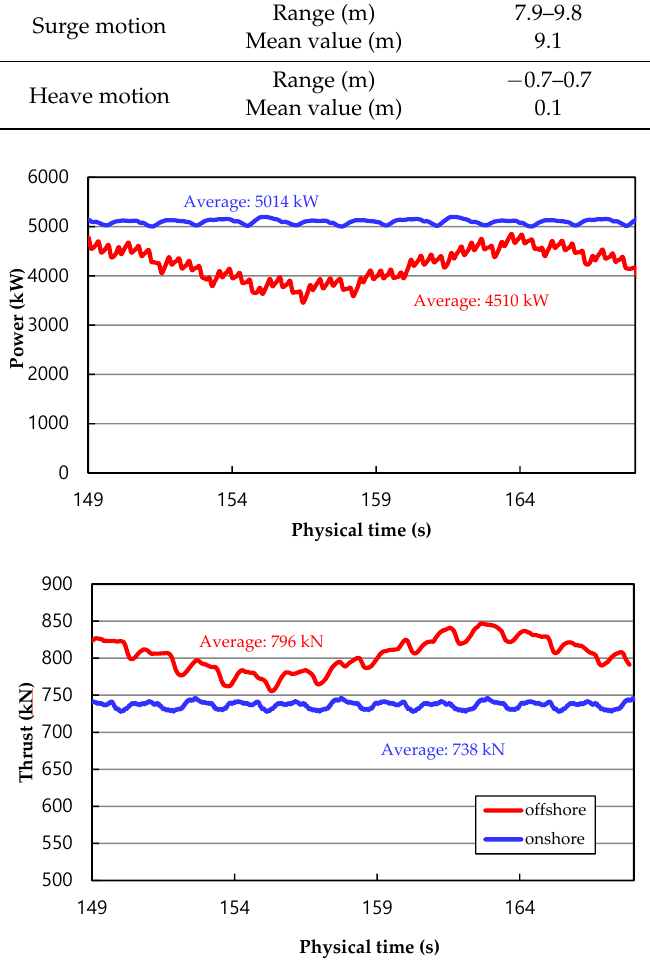
Figure 16. Comparison between onshore and offshore.